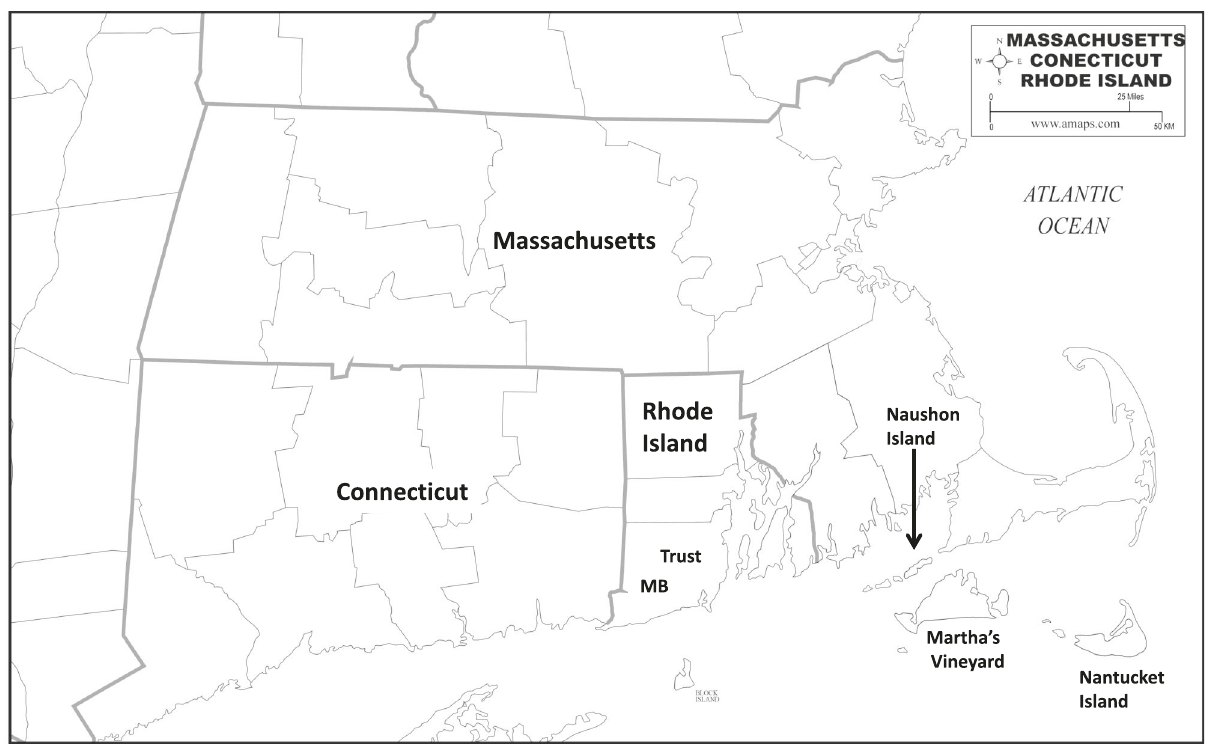
Fig. 1 Map of the fi eld sites included in this study. Ticks were collected from two sites in Washington County, Rhode Island, MB and Trust, as well as, from three islands off the coast of Massachusetts: Nantucket, Martha ’ s Vineyard, and Naushon Island.